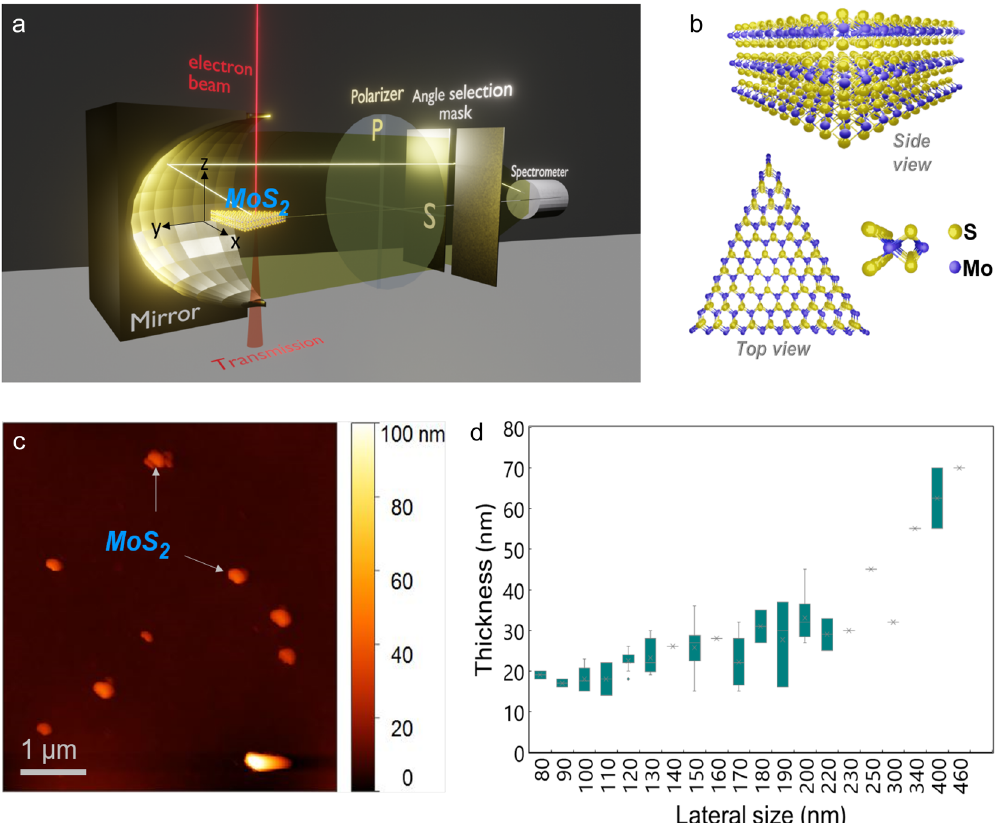
Figure 1: Experimental CL-STEM setup and sample morphology. (a) Schematic illustration of STEM-CL system. (b) The crystal structure of a triangular multiple-layer MoS 2 . In monolayer MoS 2 , molybdenum atoms (blue)are sandwichedbetweentwo layersof sulfuratoms (yellow).(c) AFMimageof MoS 2 fl akesona fl at substrate.(d) Lateralsizeand thickness relation of the fl akes measured by